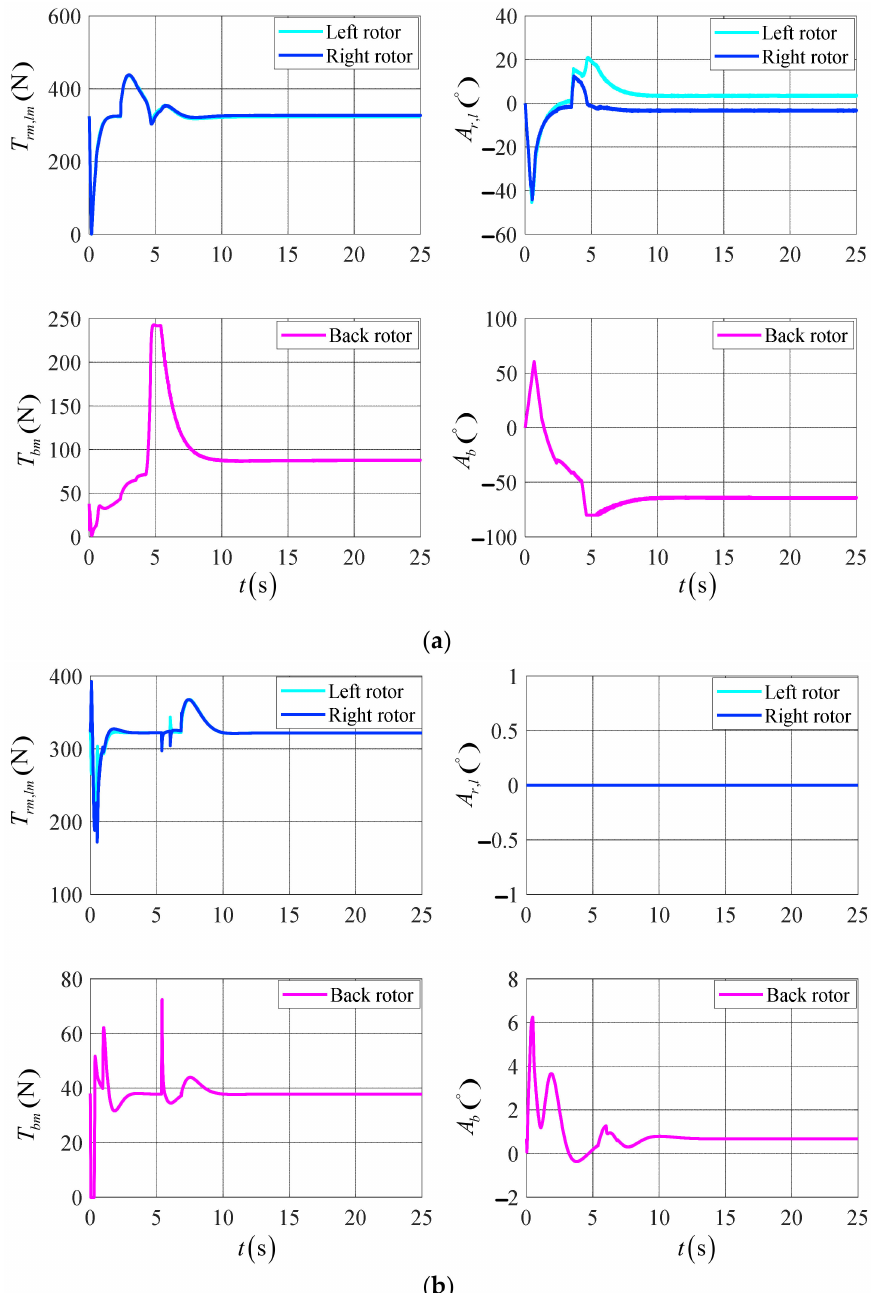
Figure 16. The variation of the UAV actuators’ control in landing. ( a ) The results of the DTVC scheme; ( b ) the results of the conventional control